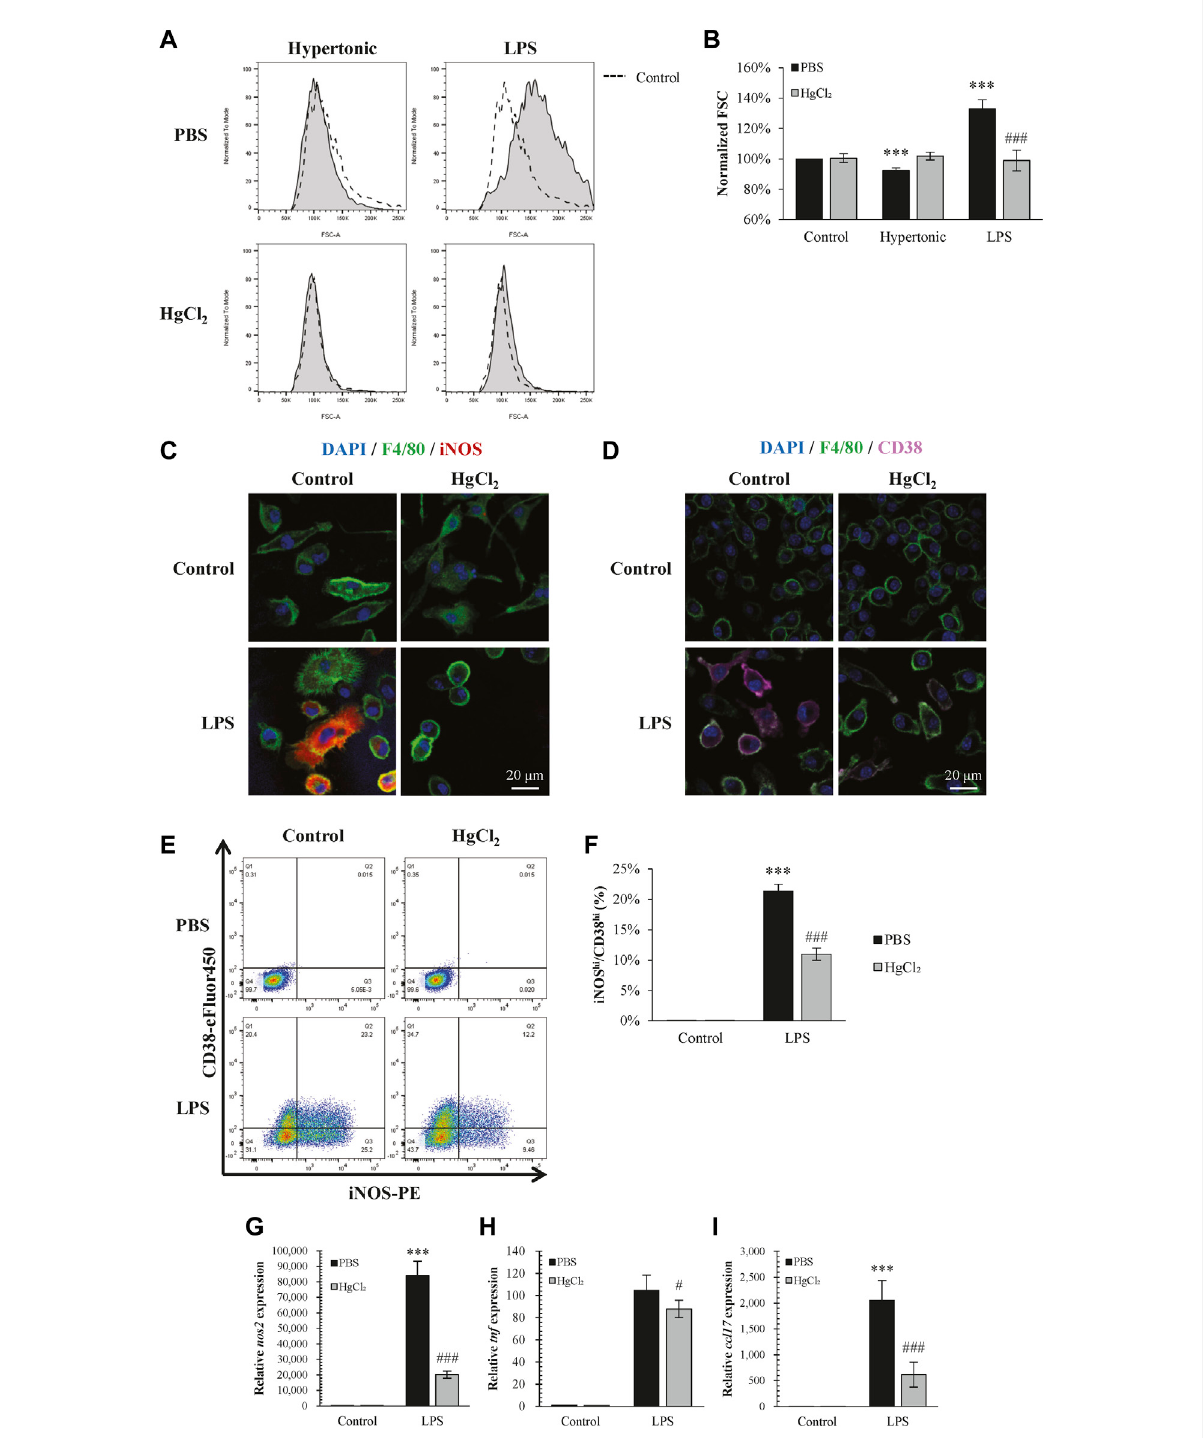
FIGURE 2 HgCl 2 restricts lipopolysaccharides (LPS)-induced cell swelling and inhibits M1 polarization. (A,B) Normalized forward scatter (FCS) in fl ow cytometry was used to determine the relative cell size 24 h after tonicity (+20 mM NaCl) and LPS (1 μ g/ml) treatment and HgCl 2 (1 μ M) pre- treatment. ( n = 5 – 7). (C,D) Immuno fl uorescence image showing iNOS and CD38 staining 24 h after LPS (1 μ g/ml) treatment and HgCl 2 (1 μ M) pre- treatment. (E,F) M1 polarization of bone marrow-derived macrophages (F4/80+ and CD11b+) were estimated by iNOS and CD38 in fl ow cytometry ( n = 4 – 7). (G – I) M1-related gene expression were evaluated by TaqMan ™ qPCR assay 4 h after LPS treatment ( n = 3). Values are mean ± SEM. *** p < 0.001 vs. control. # p < 0.05 vs. LPS. ### p < 0.001 vs.